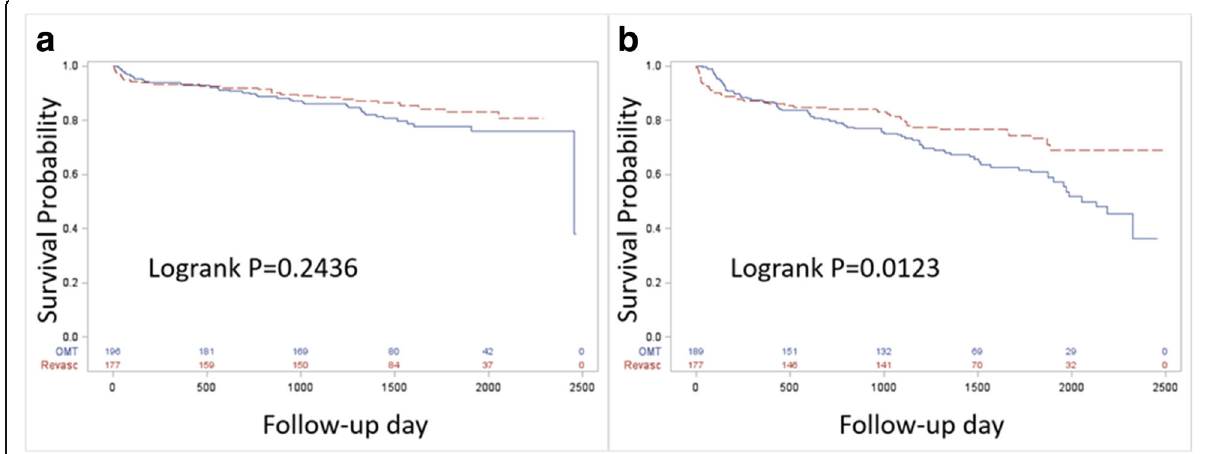
Fig. 3 Comparison of survival curves among patients with a risk score lower than the median ( a ) and higher than the median ( b ). Low-risk patients have similar rates of event-free survival (logrank P =0.2436). Among high-risk patients, those randomized to prompt CABG have improved rates of event-free survival (logrank P =0.0123). Blue lines represent subjects randomized to IMT, and red lines represent those randomized to prompt